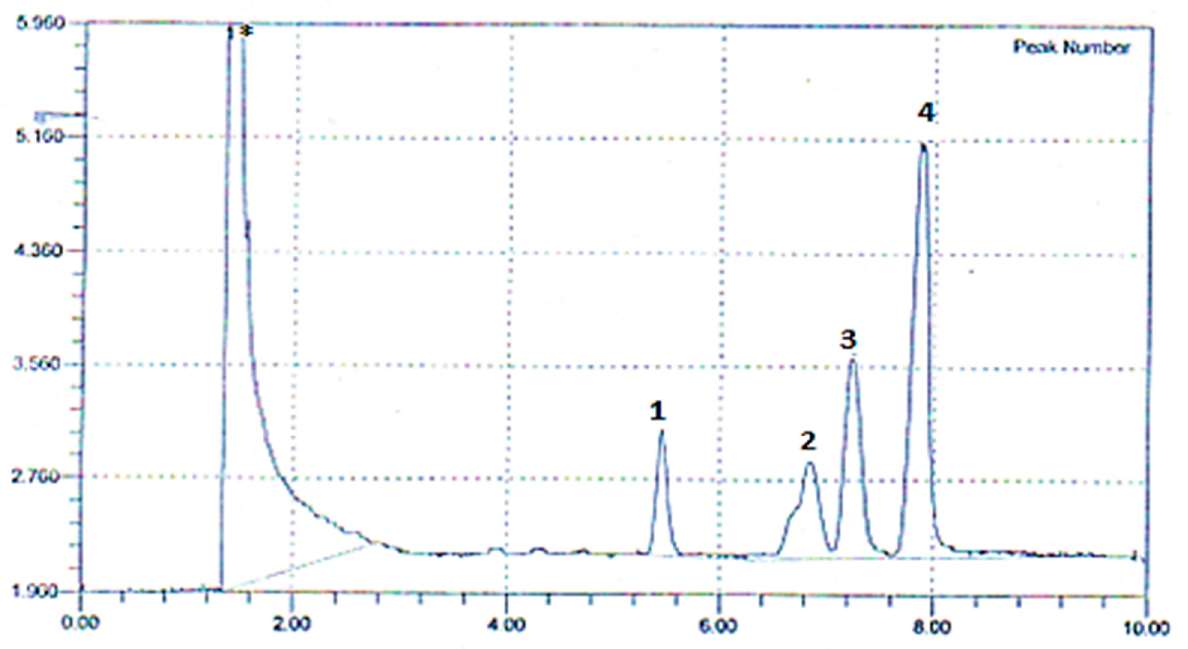
Figure 12. Untreated (control) GLC. (* is the solvent, 1 is the palmitic acid, 2 is oleic acid, 3 is a Linoleic acid and 4 is the α - α linolenic acid ) of chia ( Salvia hispanica L.) fixed oil content as impacted by various bio-stimulating materials.